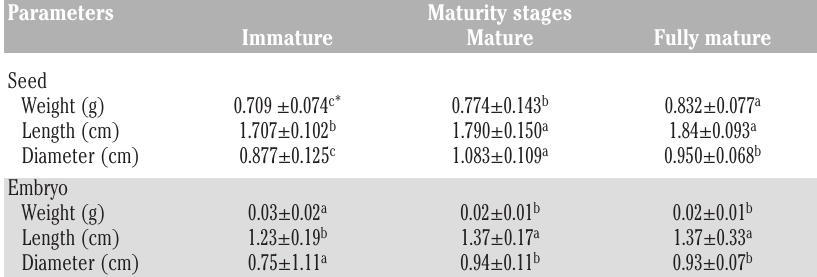
Table 2. Characteristics of the seed and embryo of J. curcas harvested at three different maturity